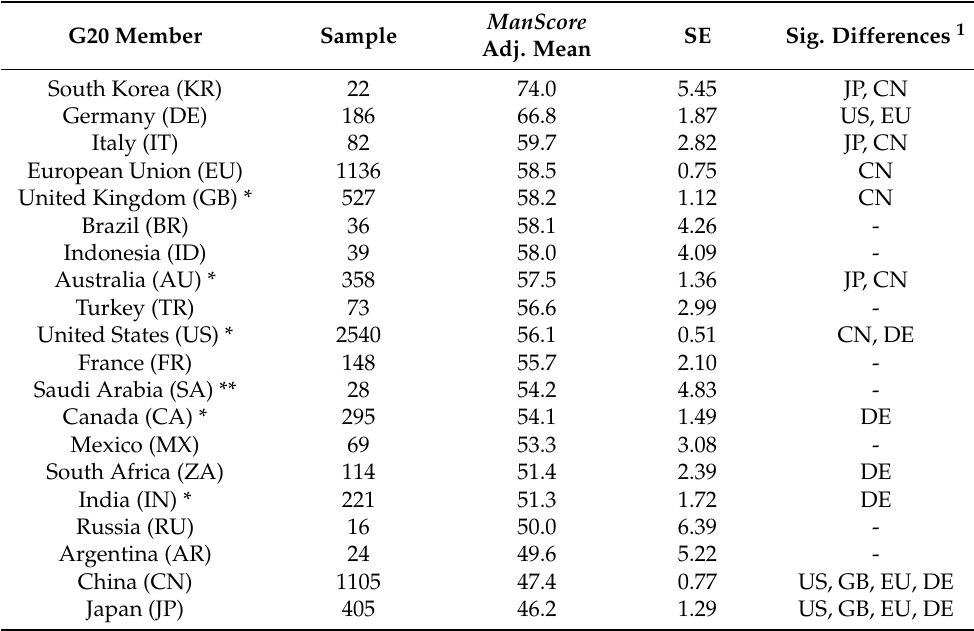
Table 2. The analysis of covariance of ManScore by country/group of countries, adjusted for company size, in descending order.